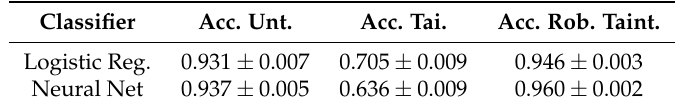
Table 3. Accuracy of two classifiers on clean (untainted), and attacked (tainted) data, with and without